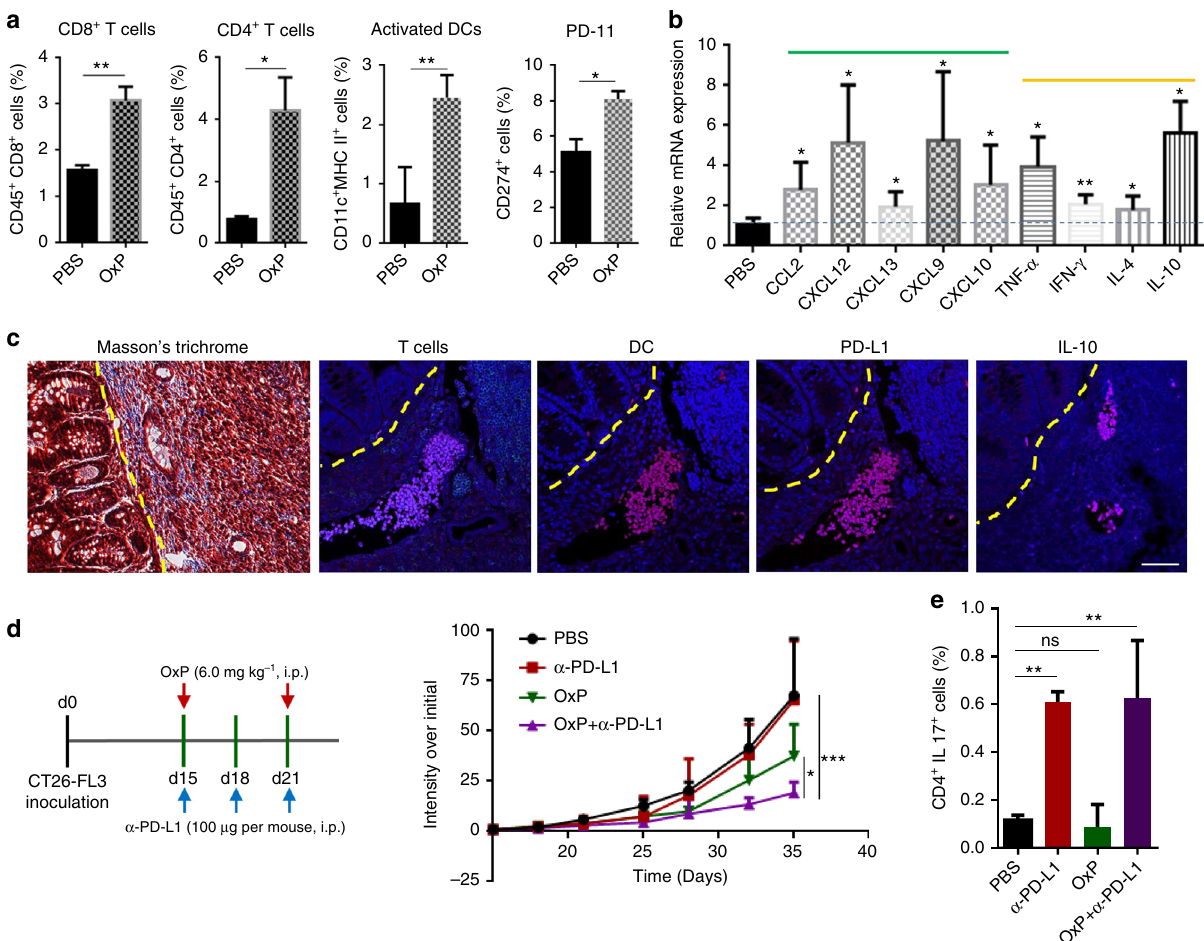
Fig. 3 OxP induces immune microenvironment changes and synergizes with α -PD-L1 in CT26-FL3 tumor therapy. a CD8 + T cells, CD4 + T cells, activated DCs and PD-L1 levels in tumors of the PBS and OxP-treated groups on day 28, analyzed by fl ow cytometry ( n = 4). b Relative mRNA expressions of various cytokines in tumors of the OxP-treated group compared to PBS group on day 28, detected by quantitative RT-PCR ( n = 4). c Masson ’ s trichrome and immuno fl uorescence staining of the orthotopic tumors after OxP treatment using DAPI (blue), anti-CD3 (red), anti-CD11c (red), anti-CD274 (red), and anti-IL-10 (red). Yellow dotted line indicates the border between intestinal mucosa and the orthotopic tumor. Scale bar represents 50 μ m. d Treatment scheme and tumor growth curves of orthotopic CT26-FL3 tumors in PBS, α -PD-L1, OxP, and OxP + α -PD-L1 treated groups ( n = 5 mice per group). e Th17 cell ratios in the splenocytes of the mice after various treatments on day 28 ( n = 4). Signi fi cant differences were assessed in d using two-way ANOVA with multiple comparisons and in a , b , and e using t test. Results are presented as mean (SD). ns not signi fi cant. * P < 0.05, ** P < 0.01, *** P <